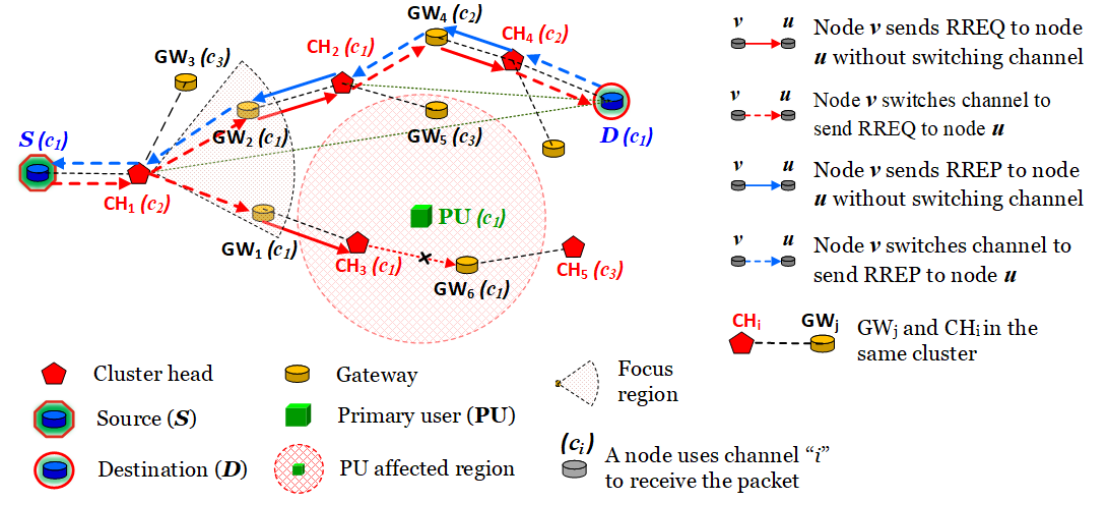
Figure 6. The basic concept of proposed routing